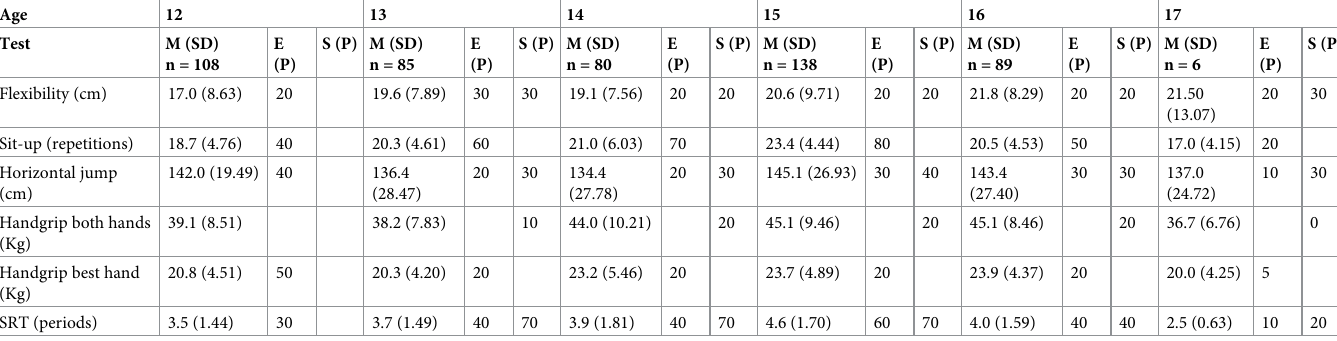
Table 3. Descriptive data of physical fitness test results by age in girls with comparative percentile based on baseline data.